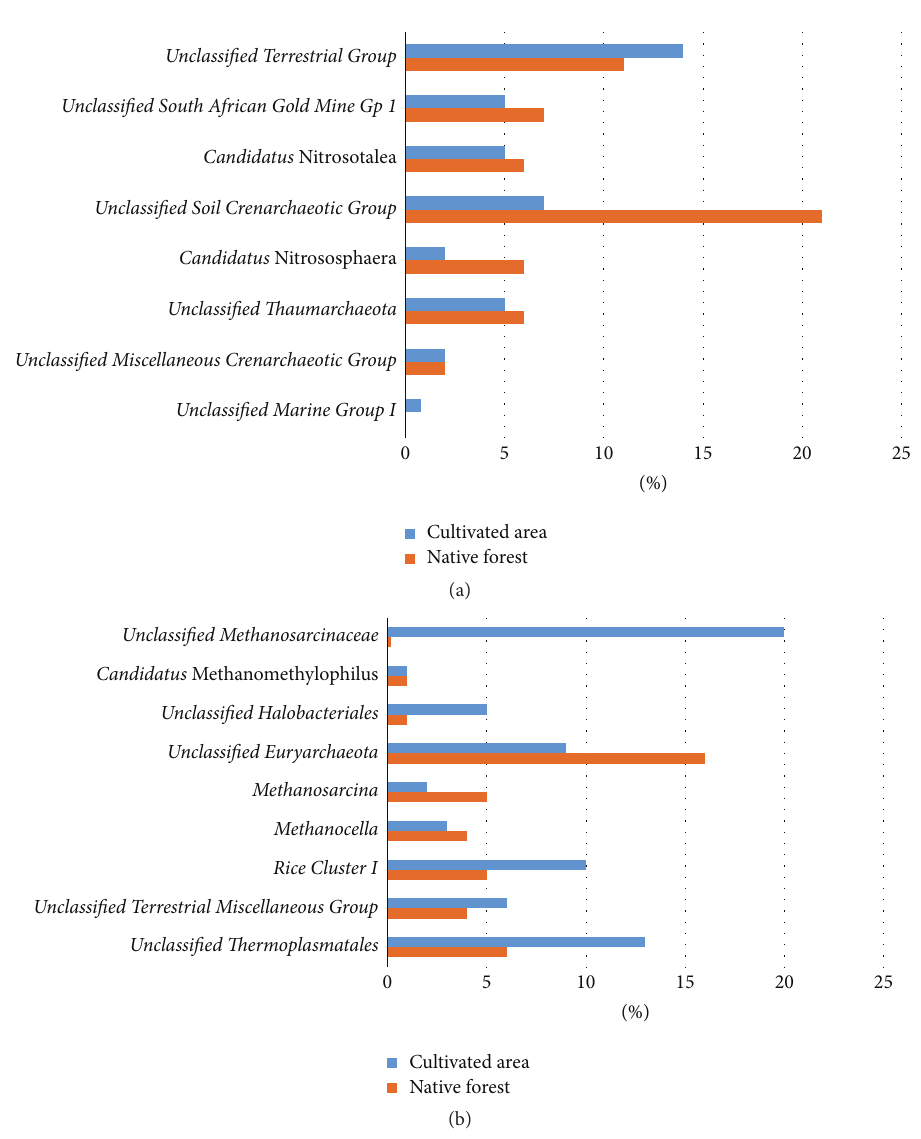
Figure 6: Percentage of archaeal operational taxonomic units within the Thaumarchaeota (a) and Euryarchaeota (b) phyla classified at the genus level for native forest soil (orange) and soil under oil palm cultivation (blue). The percentage of unclassified sequences at genus level is